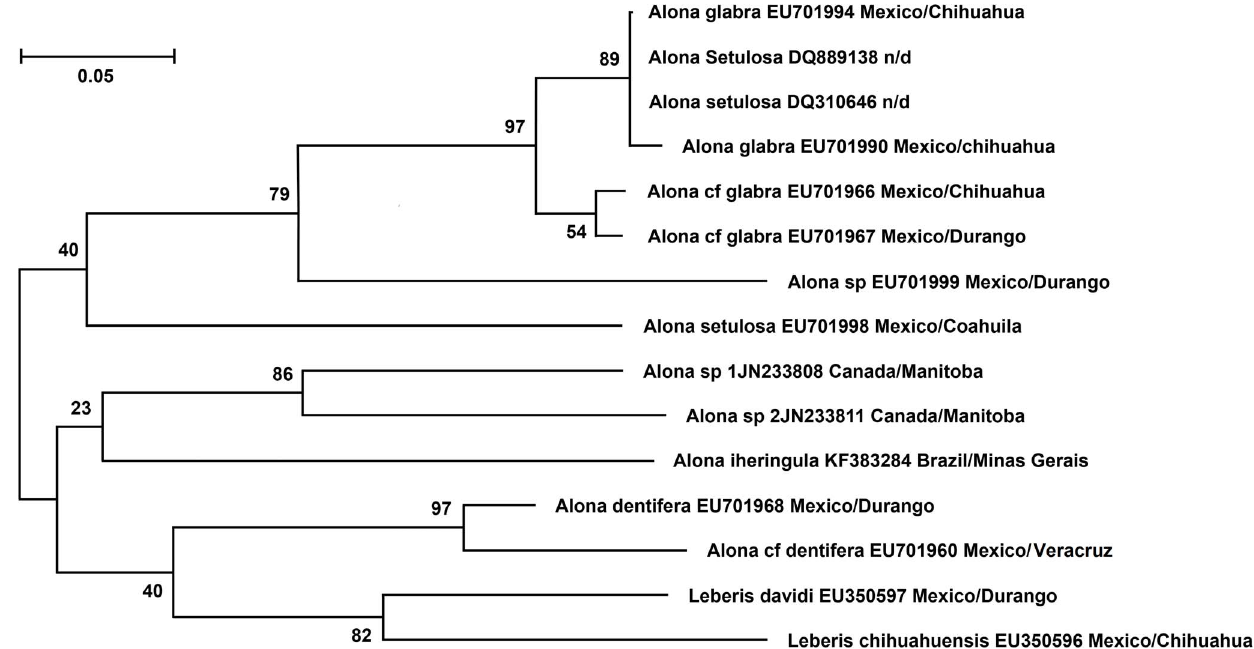
Figure 3. Identification COI tree of Alonaiheringula and other Alona and Leberis species using a 461bp-COI fragment inferred by ML. Tree with the highest log likelihood (-2487.9868) is shown. Numbers in each node designate percentage of bootstrap support (for 1000 replicates). The bar shows the number of substitutions per site. Genbank access number and locality are located after each species name. n/d: not determined. doi:10.1371/journal.pone.0097050.g003 PLOS ONE |